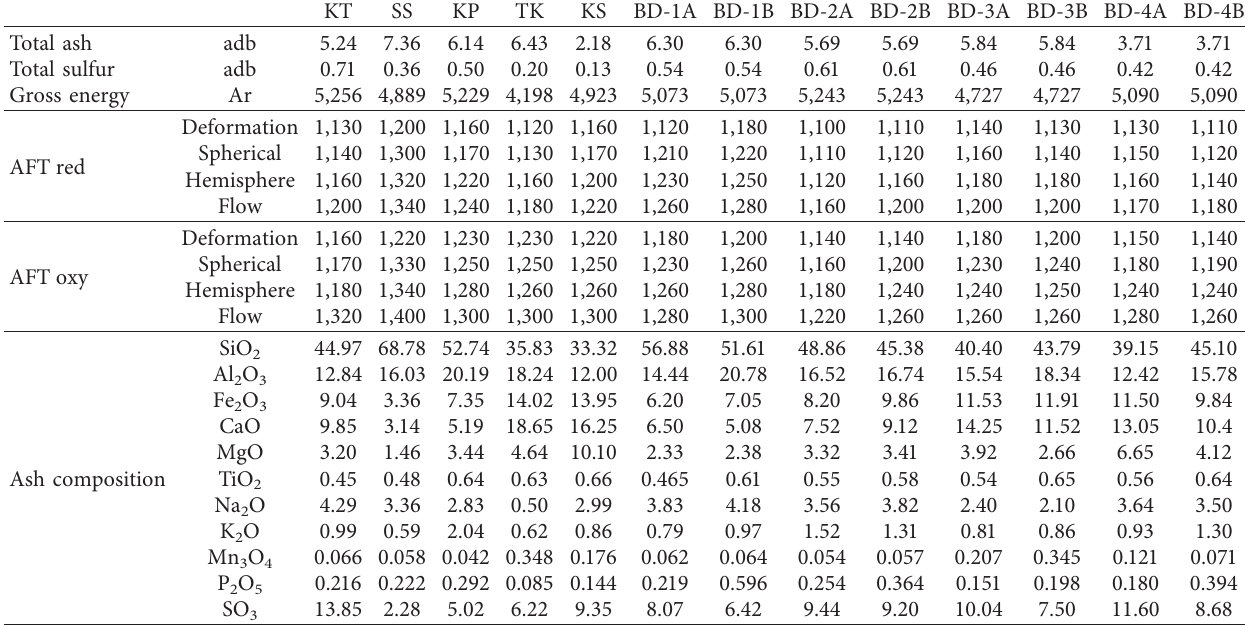
Table 1: Chemical composition of